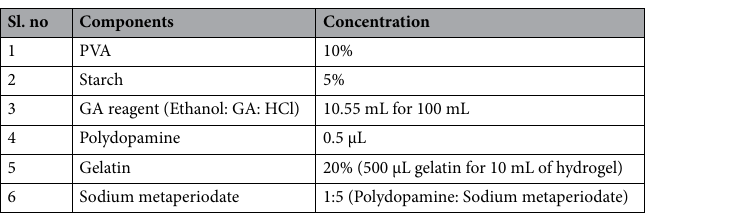
Table 11. The optimized composition of GbH. Patent application no: 202041044794, Government of India patent office, Status: Filed.